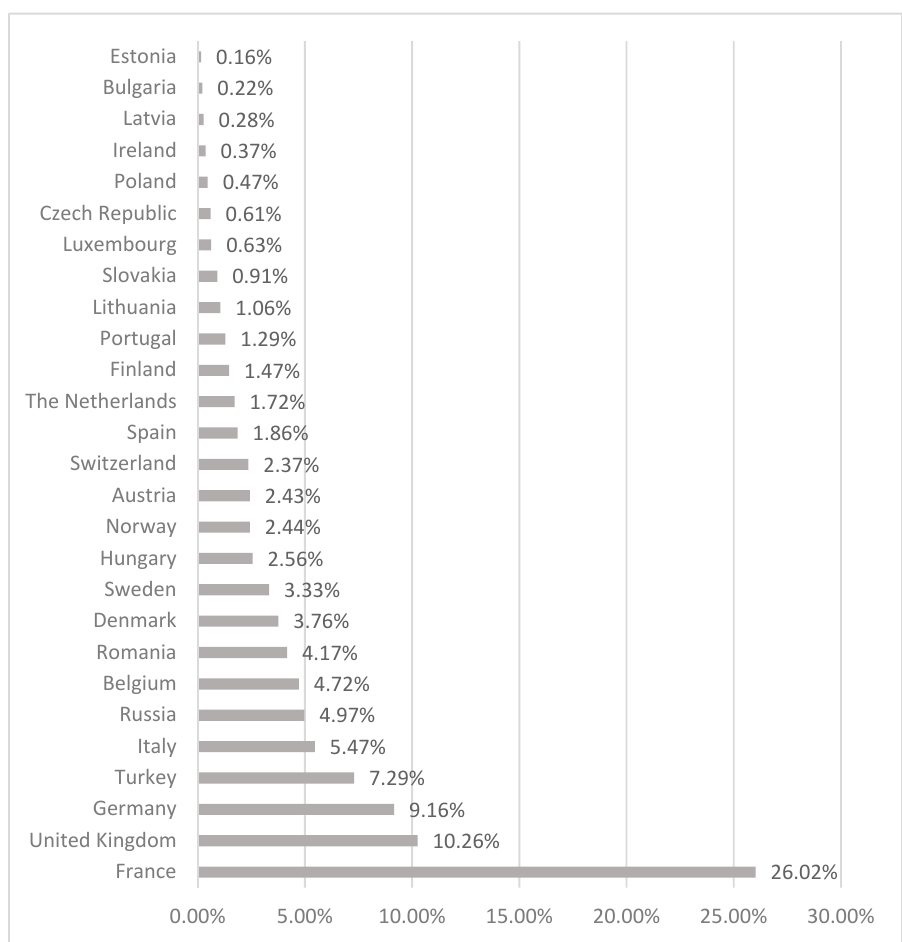
Figure 1. Frequency of corporate insolvencies in Europe, by country in 2018. Source: Euler Hermes Economic Research. 2019. Insolvency Outlook. Euler Hermes, Allianz, Economic Research, January 2019, 1–14. Own elaboration.